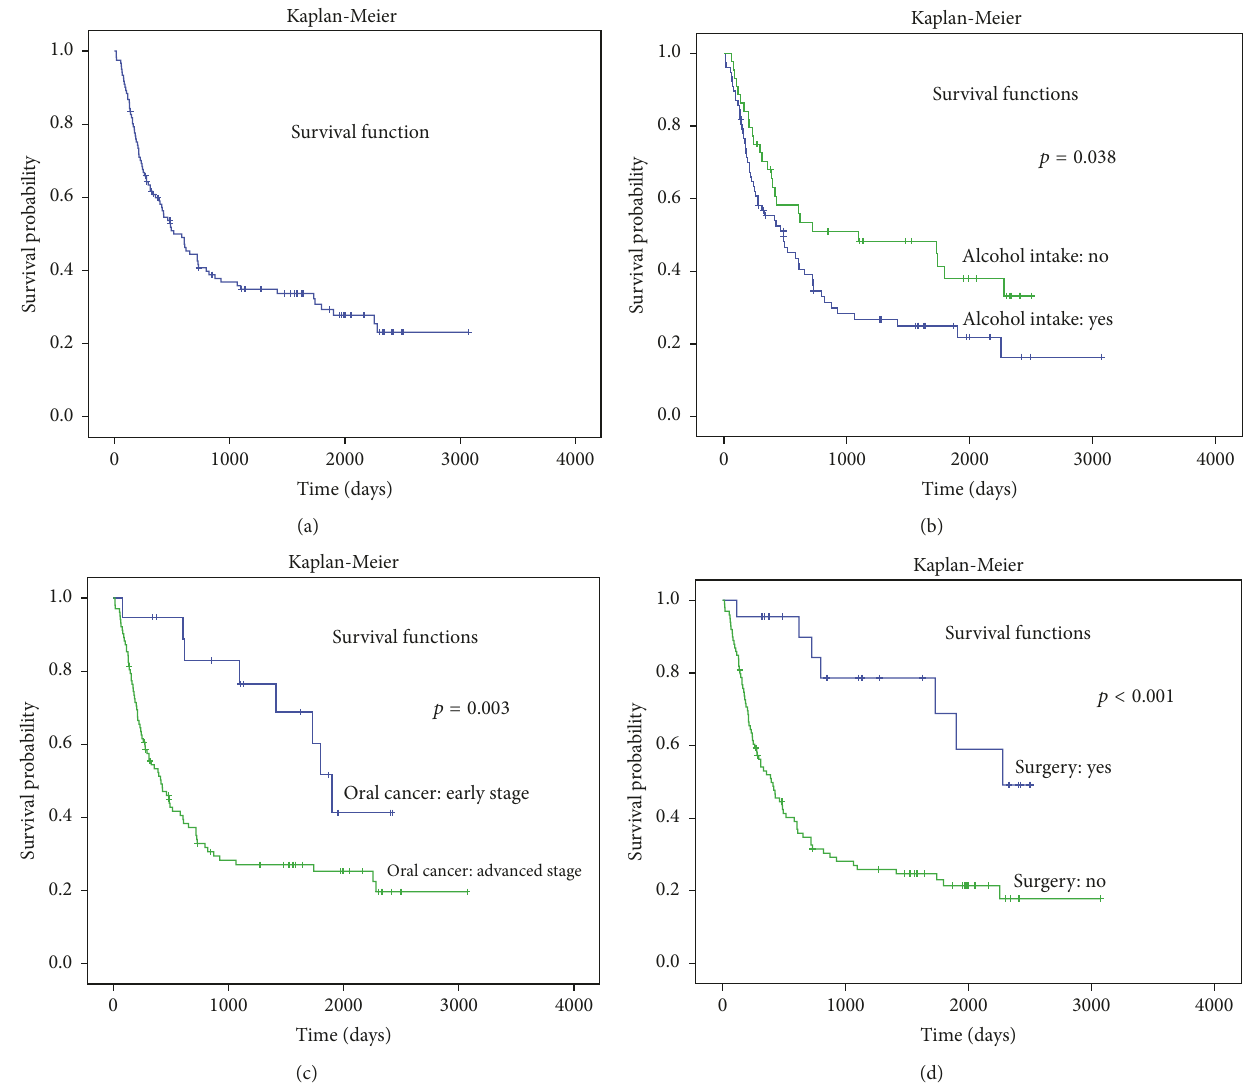
Figure 1: (a) Survival curve of patients with oral and oropharyngeal squamous cell carcinoma estimated by Kaplan-Meier method (Macei´o, AL, Brazil, 2005–2013). (b) Survival curve for alcohol intake of patients with oral and oropharyngeal squamous cell carcinoma estimated by Kaplan-Meier method (Macei´o, AL, Brazil, 2005–2013). (c) Survival curve for cancer staging of patients with oral and oropharyngeal squamous cell carcinoma estimated by Kaplan-Meier method (Macei´o, AL, Brazil, 2005–2013). (d) Survival curve for surgical procedure of patients with oral and oropharyngeal squamous cell carcinoma estimated by Kaplan-Meier method (Macei´o, AL, Brazil,